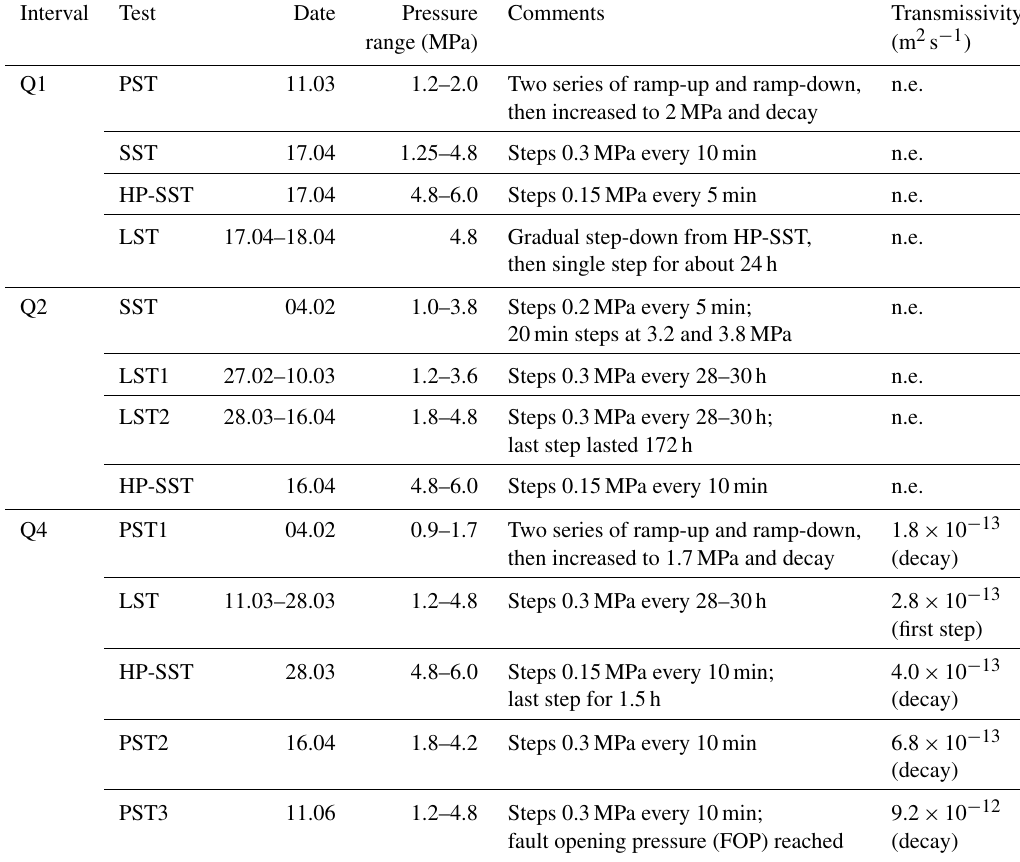
Table 3. Summary of all injection tests performed. Transmissivity has been estimated only for tests in injection interval Q4 of borehole BCS-D1 (n.e.: not estimated). We calculated transmissivity only for this interval, as only when injection occurred here was there a response in the monitoring borehole (BCS-D2). Note that the transmissivity was always estimated by modeling the injection pressure and never as a cross-hole